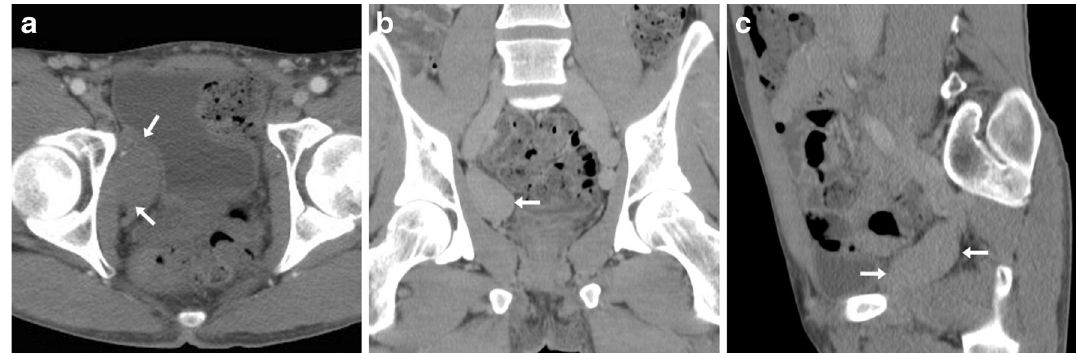
Fig. 13 Post-thrombotic aneurysmal dilatation of the right hypogastric vein in a 34-year-old male intravenous drug user with long-standing history of lower limb thrombophlebitis. Requested to investigate sepsis and suspected deep venous thrombosis, CT showed a well-demarcated ovoid mass lesion abutting the right obturator muscle, measuring 30 – 35